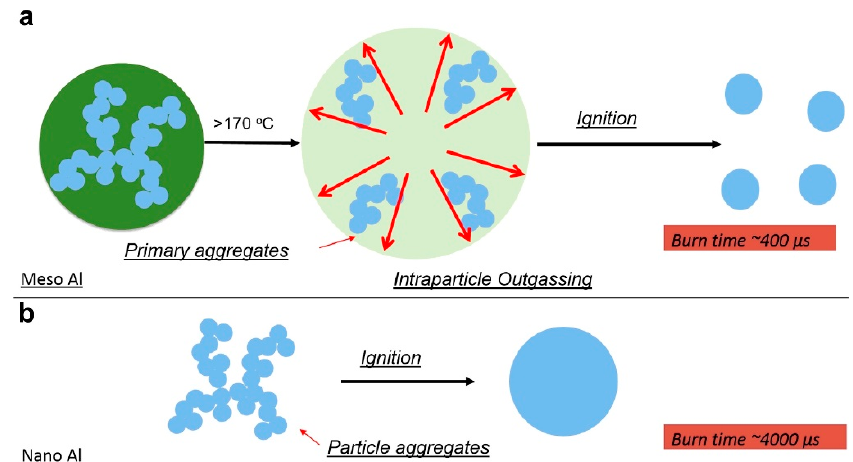
Figure 13. Overall pictures of the events occurring in the combustion of: ( a ) Al/NC mesoparticles, ( b ) Al nanoparticles ALEX. Reproduced from [48], with permission from Elsevier, 2016.